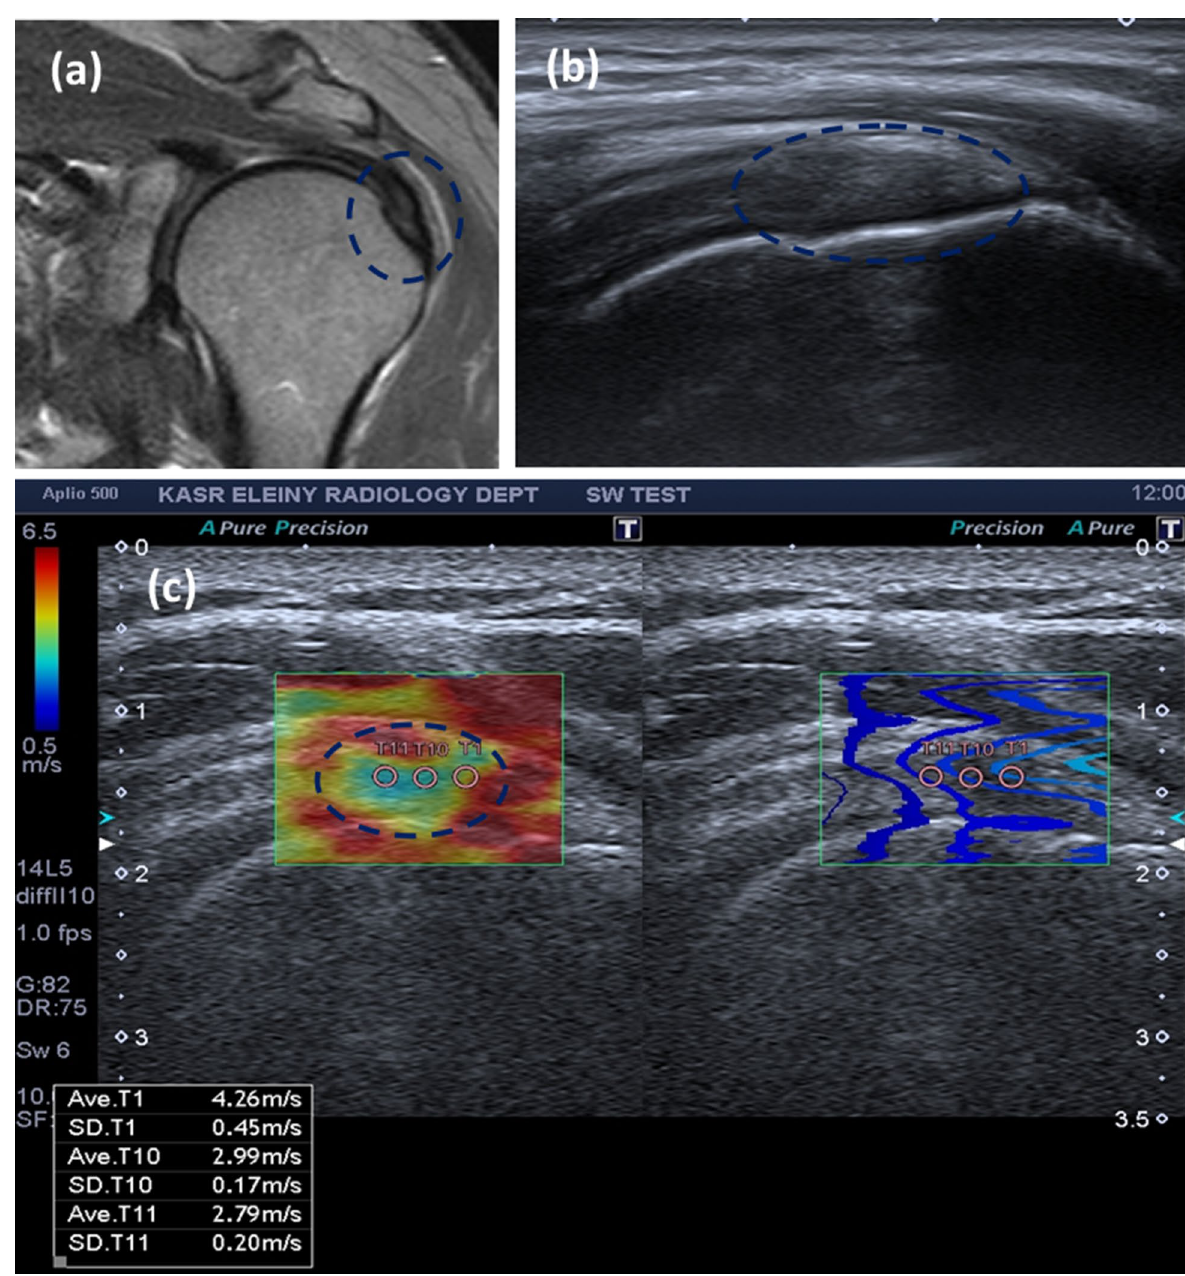
Fig. 3 a MRI coronal oblique STIR images of supraspinatus tendon showing thickened tendon with intrasubstance increased signal (grade II), b B-mode US showing thickened tendon with heterogeneous echogenicity, c shear wave elastography showing areas of tendon softening (blue color) with average SWV equals 3.2